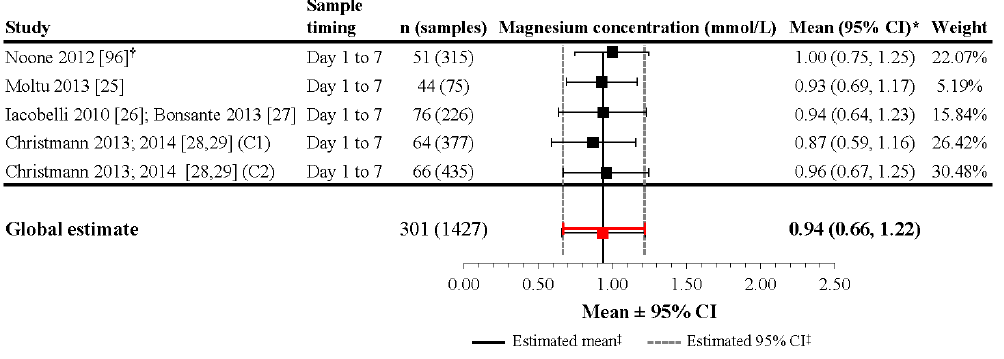
Figure 6. Magnesium concentrations during the first week of life in very-low-birth-weight newborns receiving parenteral solution. * If 95% CIs were not reported in the study, then the 95% CIs were calculated as follows: mean ± (1.96 × SD). † Patient groups within these studies were pooled, as the literature search did not confirm an association between magnesium levels and gestational age, birth weight, or mode of delivery; ‡ Reference line and 95% CI derived using only studies reporting both mean and SD data. Overall statistic for heterogeneity: I 2 = 62.8% ( p = 0.045). C1: cohort 1; C2: cohort 2; CI: confidence interval; n: number of infants; SD: standard deviation.